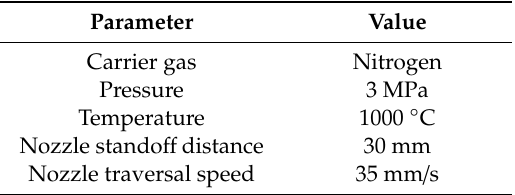
Table 2. Process parameters values of the cold-spray